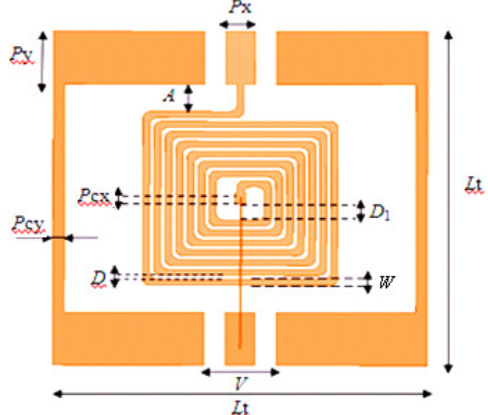
Figure 3: Pattern of the copper spiral coil with its ground shielding.